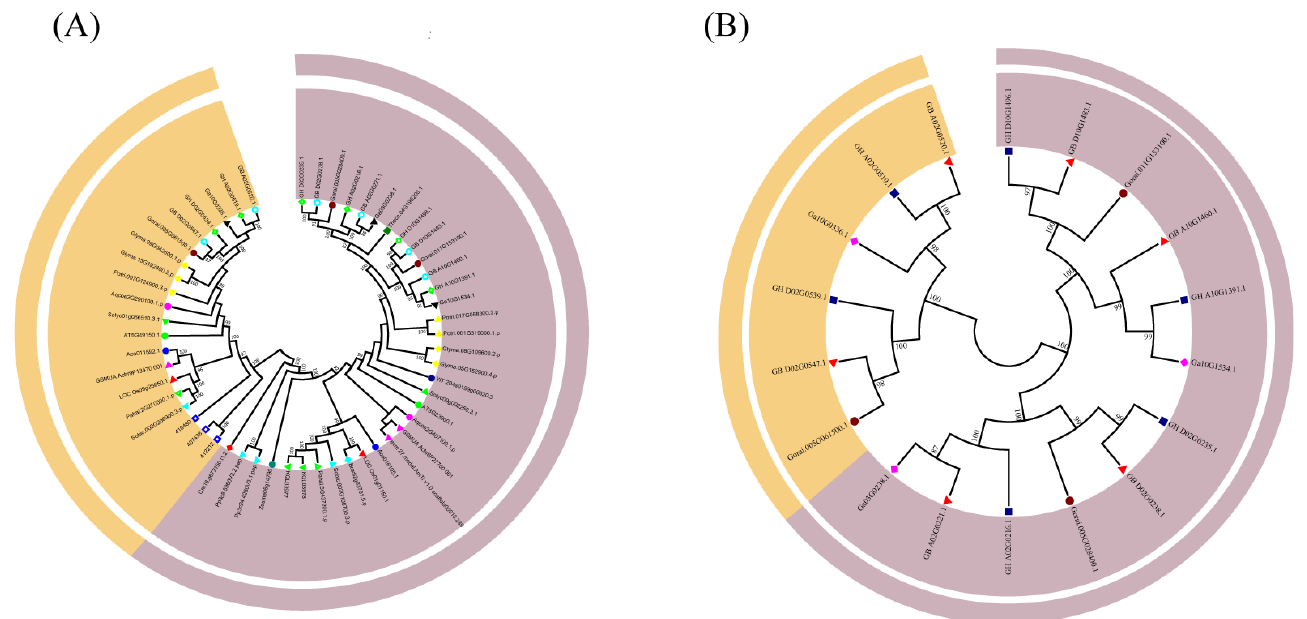
Figure 1. Two unrooted phylogenetic trees were constructed via the MEGA7 maximum-likelihood method. The percentage of replicate trees in which the associated taxa clustered together in the bootstrap test (1000 replicates) is shown next to the branches. All positions with less than 90% site coverage were eliminated. ( A ) Phylogenetic relationship of the 54 identified Filamin gene family members from Gossypium raimondii and 19 other plant species. ( B ) A phylogenetic tree of Filamin gene family members in four cotton species.